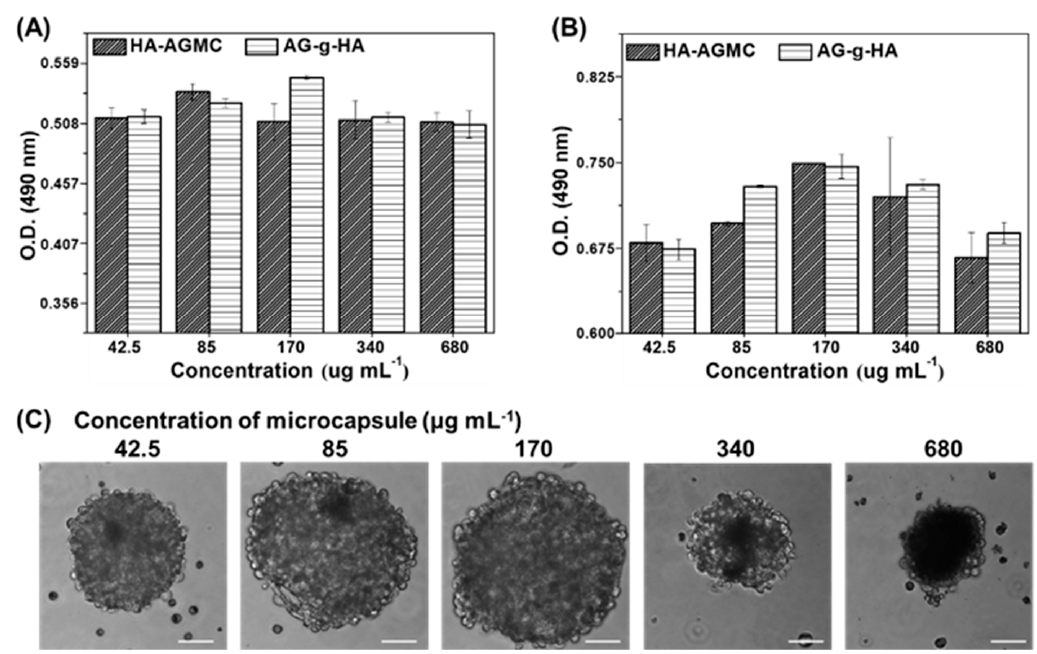
Figure 4. Cartilage tissue-mimetic pellets proliferation and morphology. The relative cell proliferation after culturing chondrocytes with HA-AGMCs microcapsule or AG-g-HA at different concentrations (from 42.5 to 680 μ g mL − 1 ) at ( A ) 7 days and ( B ) 14 days (n = 4). ( C ) The cell pellet morphologies after culturing 14 days showed that HA-AGMCs at the concentration of 170 μ g mL − 1 had the biggest pellet size of 200 μ m. Scale bar = 50 μ m.